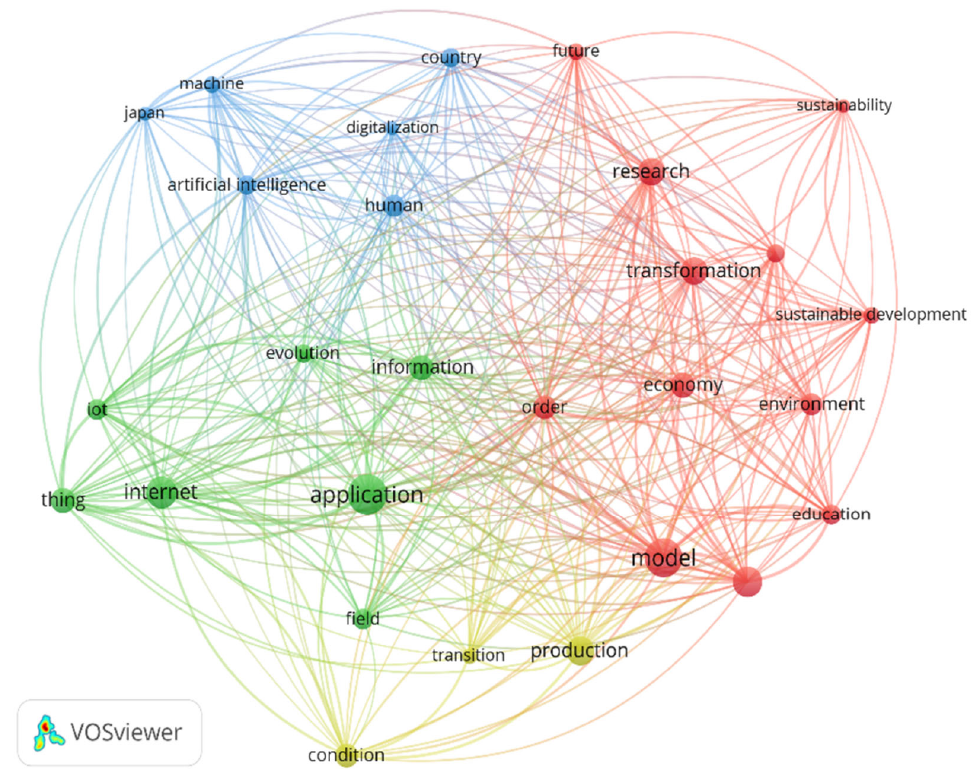
Figure 2. The Network Visualization of Literacy Topic Area.